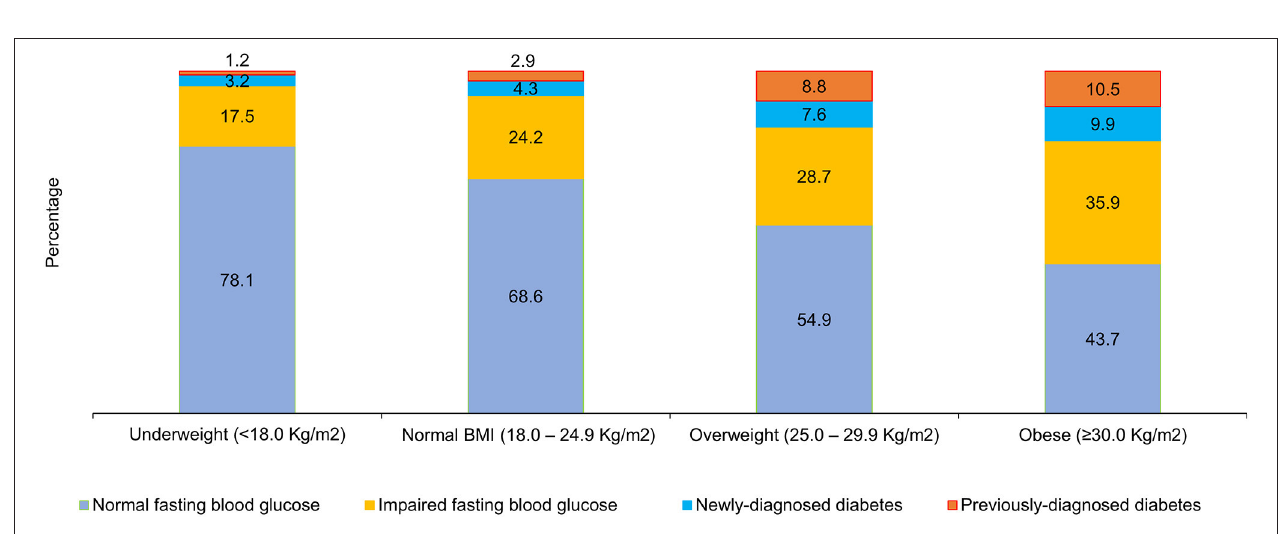
FIGURE 3 | Distribution of fasting blood glucose among adults (18–69 years) by BMI